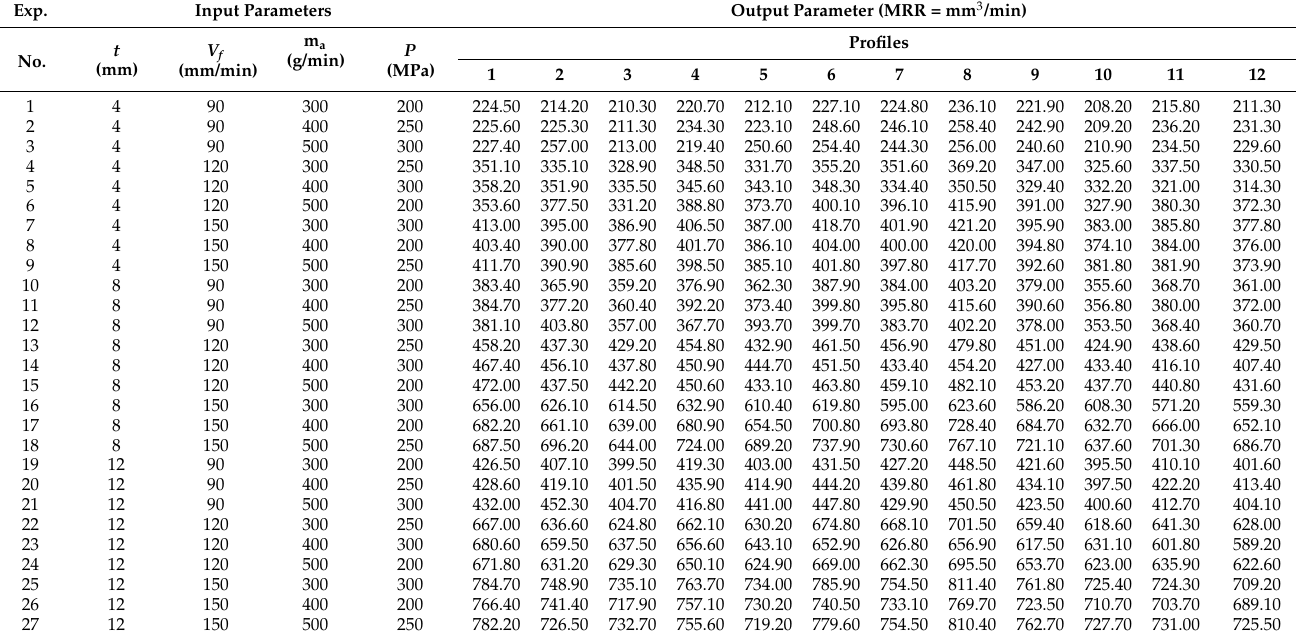
Table 6. The L 27 orthogonal array of Taguchi for material removal rate